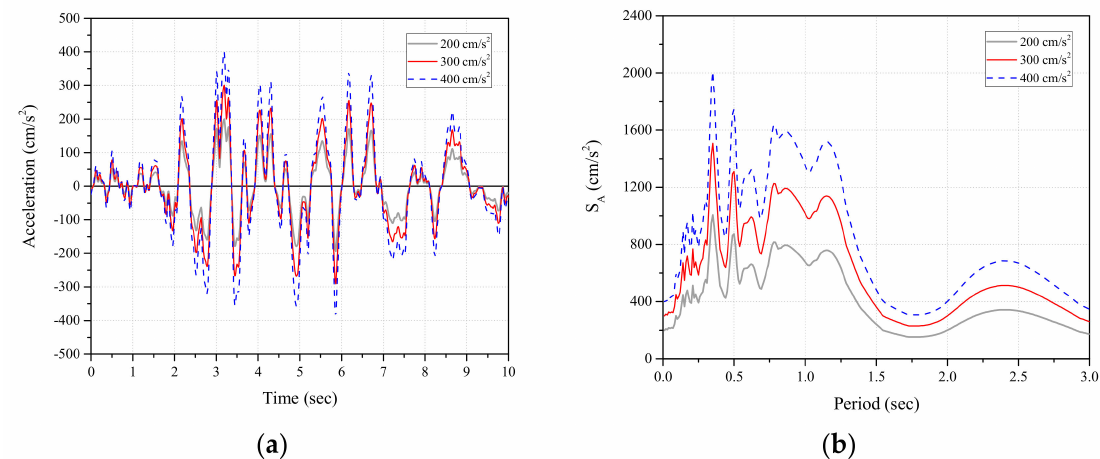
Figure 13. Ground motion accelerations used in the pseudo-dynamic test: ( a ) time history records and ( b ) acceleration response